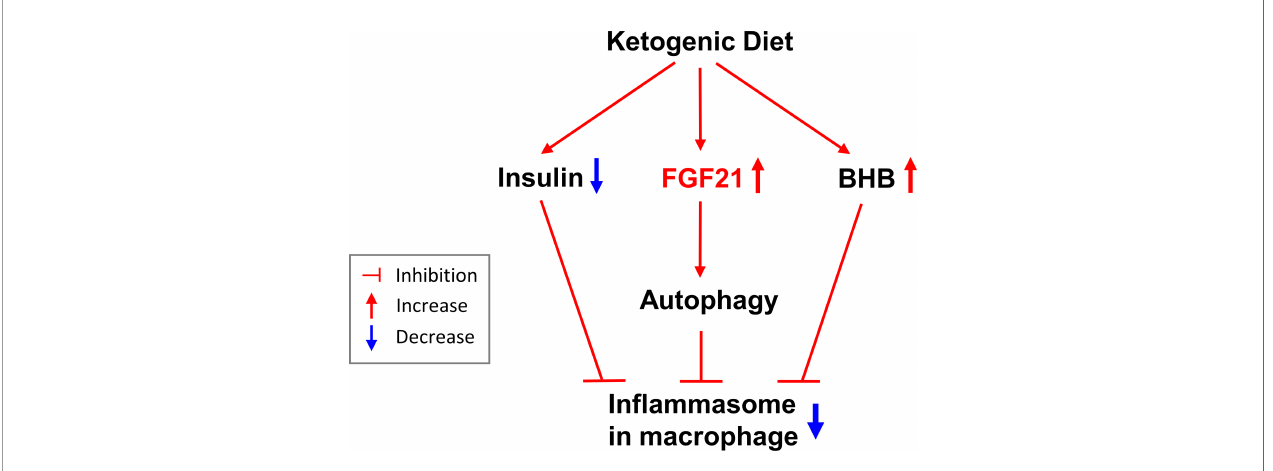
FIGURE 5 | The summary of effects of the isocaloric ketogenic diet.